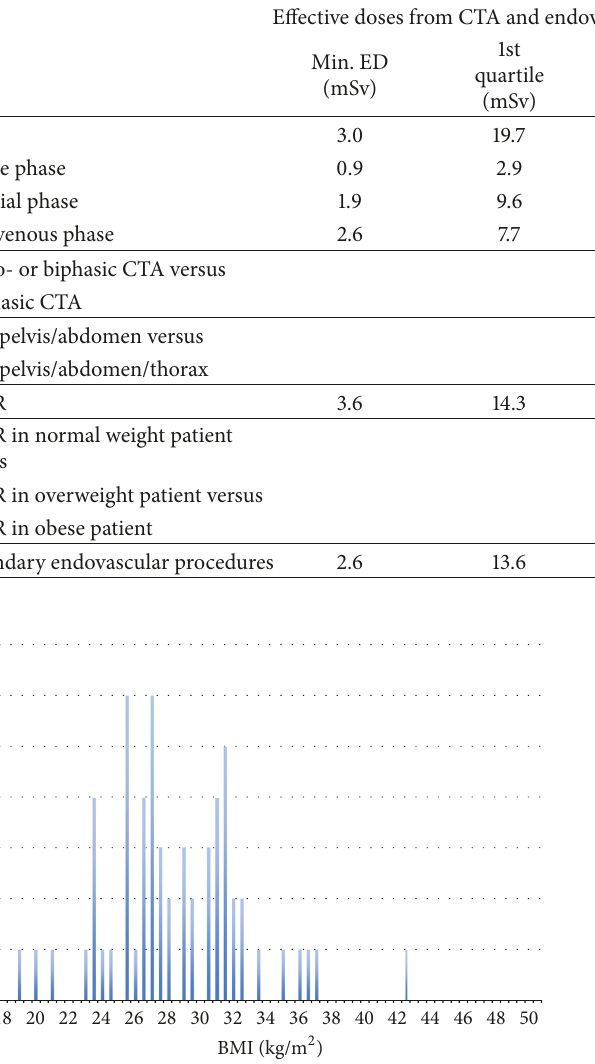
Figure 1: Distribution of the study population over the WHO body mass classes, with dotted lines separating “underweight/normal weight,” “overweight,” and “obese.”